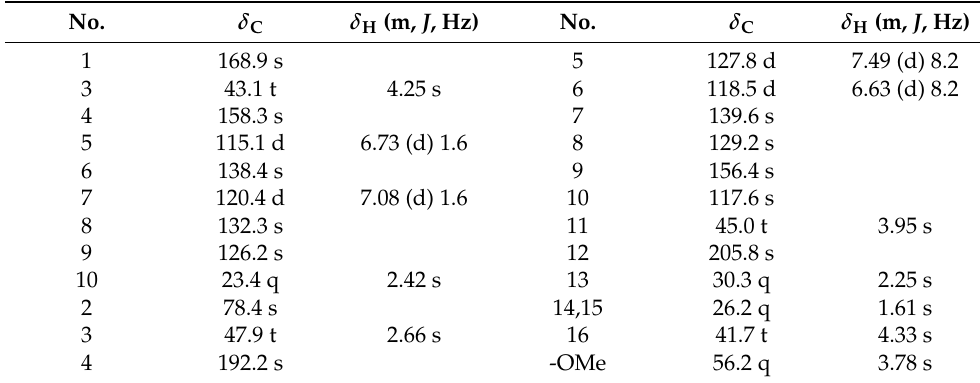
Table 3. 1 H and 13 C NMR data for compound 5 (CDCl 3 , 500 and 125 MHz).